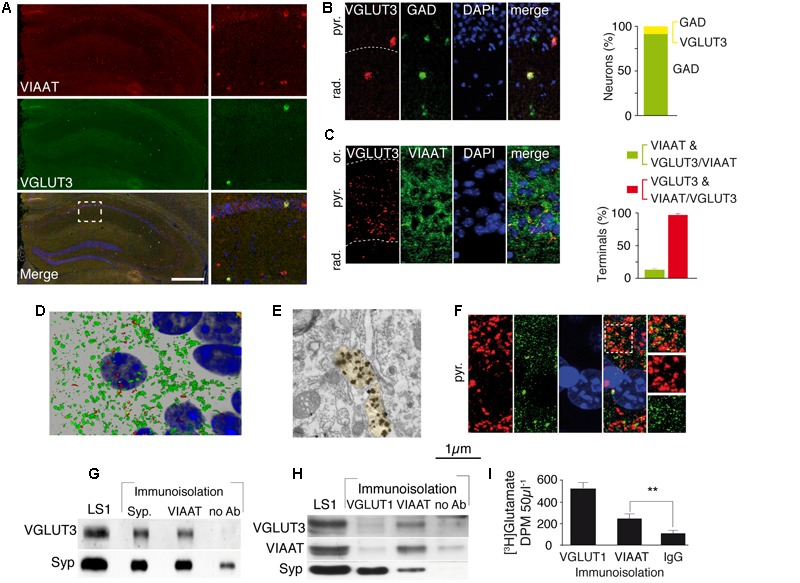
VGLUT3 is present in the GABAergic terminals and synaptic vesicles of basket cells of the CA1 layer. (A) Double FISH labeling of mRNA encoding VIAAT (red) and VGLUT3 (green) on a coronal section from WT mouse hippocampus. Nuclei were stained with DAPI (blue). An enlargement of the CA1 area is shown on right panels. (B) Double FISH labeling of mRNA encoding VGLUT3 (red) and GAD (green) in CA1 pyramidal cell layer. Nuclei are stained with DAPI (blue). Quantification of neurons synthesizing GAD (green bar) or VGLUT3 and GAD (yellow bar) (C) Immunofluorescence labeling of VGLUT3 (red), VIAAT (green), and DAPI (blue). Note the dense VGLUT3 labeling in the pyramidal cell layer (delineated by a dashed line). Histogram represents the quantification of VGLUT3 and VIAAT co-localization in GABAergic terminals from CA1 pyramidal layer. (D) 3D reconstruction of VIAAT (green)- and/or VGLUT3 (red)-positive terminals surrounding a pyramidal cell detected by its nucleus (blue). (E) VGLUT3-positive gold immunoparticles detected by electron microscopy in 2 side-by-side axo-somatic terminals (light yellow) making symmetrical synapses. (F) Frequent apposition of VGLUT3- (red) and gephyrin-(green) positive terminals. (G) Immunoisolation of synaptic vesicles from hippocampal LS1 fractions. Immunoisolated VIAAT-positive vesicles co-express VGLUT3. Synaptophysin-containing vesicles express both synaptophysin and VGLUT3 (positive control). No VGLUT3 vesicles were immunoisolated in the absence of antibodies (negative control). (H) Immunoisolated VIAAT-containing vesicles co-express VGLUT3 and synaptophysin, whereas vesicles immunoisolated with VGLUT1 co-express synaptophysin but not VIAAT or VGLUT3, which demonstrates the specificity of the immunoisolation technique. (I) Glutamate uptake measured in immunoisolated glutamatergic (VGLUT1-positive) or GABAergic (VIAAT-positive) vesicles. VIAAT-isolated vesicles take up glutamate to a lesser extent than pure glutamatergic vesicles but to a significantly greater extent than the negative control (IgG). Scale bars in (A): 500 μm in A (insets: 150 μm); 40 μm in (B) and (F); 30 μm in (C), 10 μm in (D); 0.250 μm in (E). ∗∗P < 0.01.